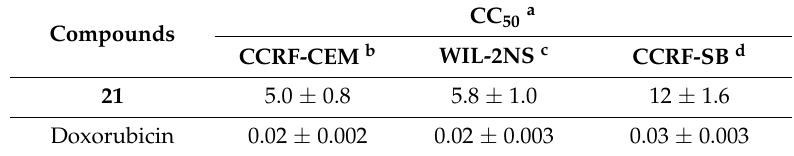
Table 8. Cytotoxicity of tryptamine derivative 21 against human leukaemia/lymphoma cell lines.